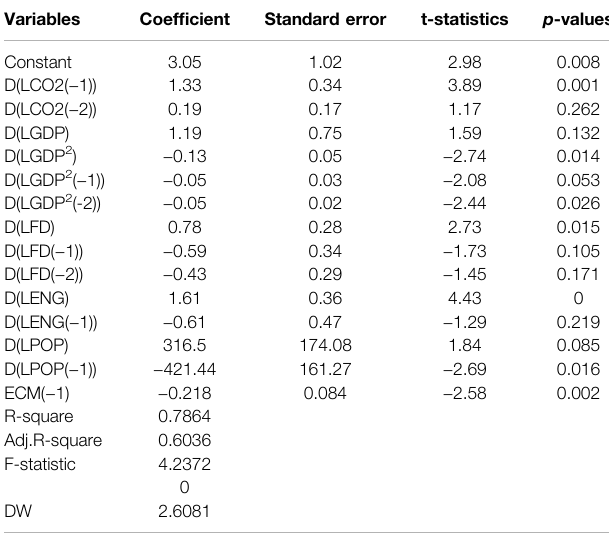
TABLE 5 | Parsimonious estimation for short-run